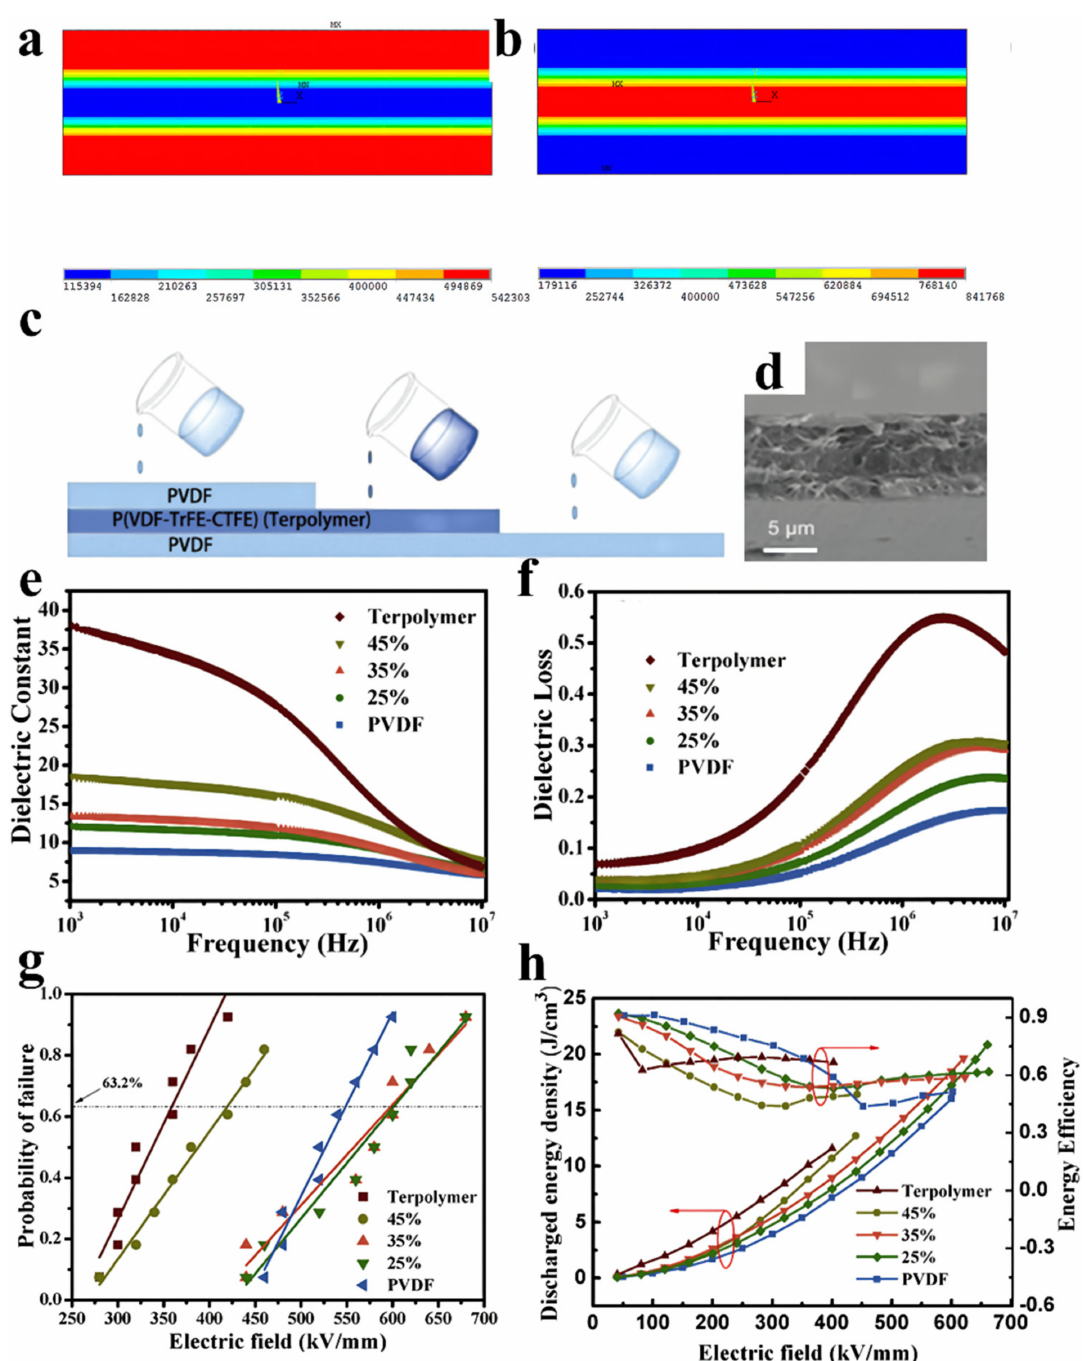
Figure 4. Finite element simulation of the distribution of the electric field in ( a ) the PVDF/P(VDF- TrFE-CTFE)/PVDF composites and ( b ) the P(VDF-TrFE-CTFE)/PVDF/P(VDF-TrFE-CTFE) com- posites. ( c ) Schematic of the fabrication process. ( d ) Cross-section SEM image of sandwich- structured composites with various contents of P(VDF-TrFE-CTFE): 35 vol.%. ( e ) Dielectric constant. ( f ) Dielectric loss of sandwich-structured composites as a function of frequency. ( g ) Weibull distribu- tion of the breakdown strength. ( h ) Discharged energy density and energy efficiency of pure PVDF, terpolymer, and sandwich-structured composites with different contents of terpolymers. Adapted with permission from [34], Copyright © 2022